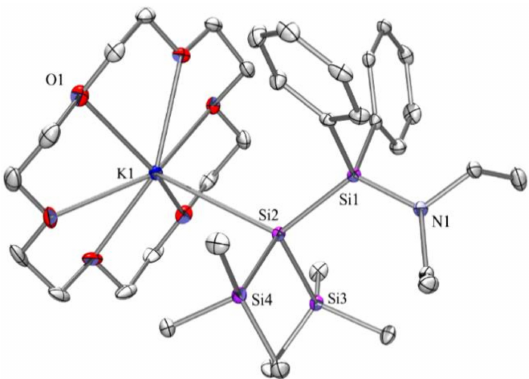
Figure 2. Molecular structure of 1a (thermal ellipsoid plot drawn at the 30% probability level). All hydrogen atoms are omitted for clarity (bond lengths in Å, angles in degrees). Si(2)-Si(1)